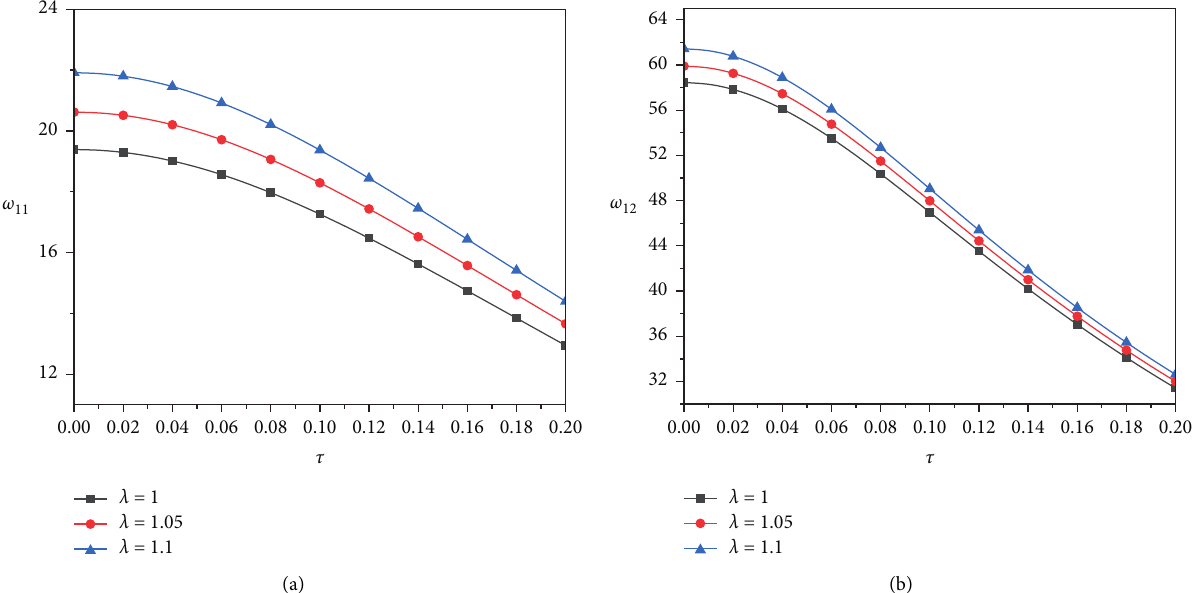
Figure 9: Variation of the vibration frequency with respect to the nonlocal parameter under different aspect ratios. (a) The first-order vibration frequency. (b) The second-order vibration